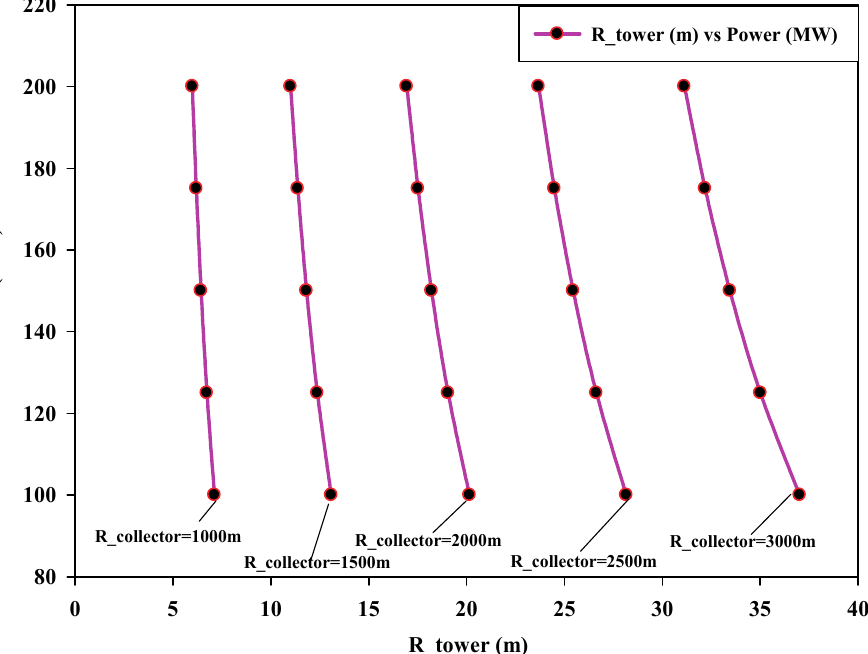
Figure 15. Effect of variation in power output on tower radius ( R Tower ) for different collector radii ( R collector ) in SUTPP.